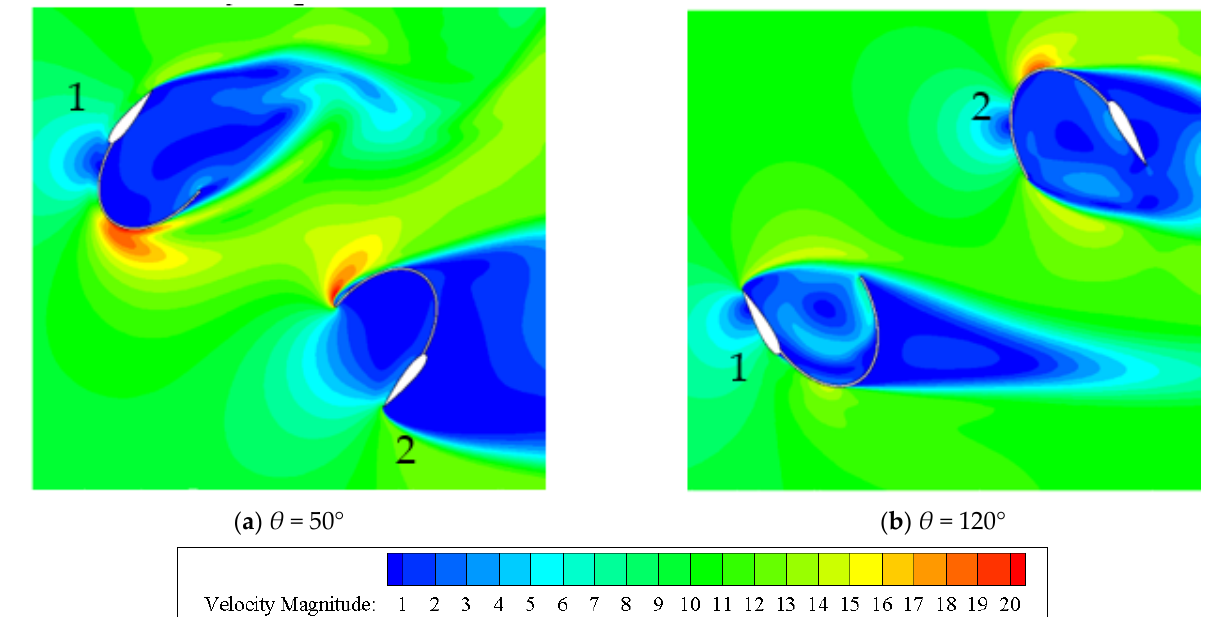
Figure 11. Velocity magnitude of 2-bladed LDCS ( U = 6 m/s): ( a ) θ = 50 ◦ ; ( b ) θ = 120 ◦ .